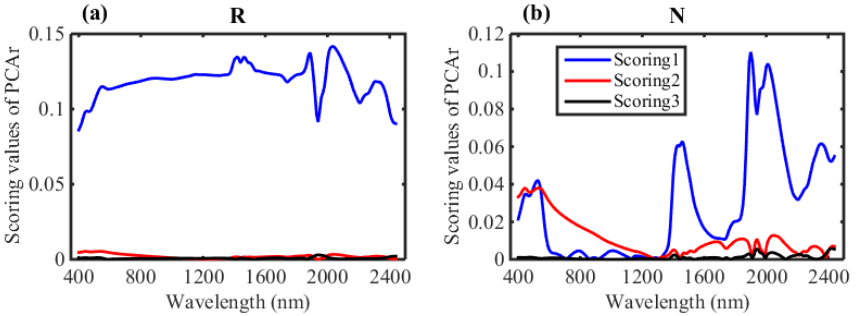
Figure 3. Cont. Figure 3.